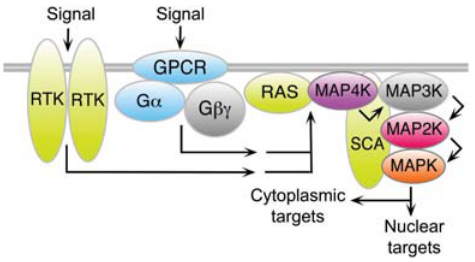
Figure 1 Typical MAPK signaling pathways.